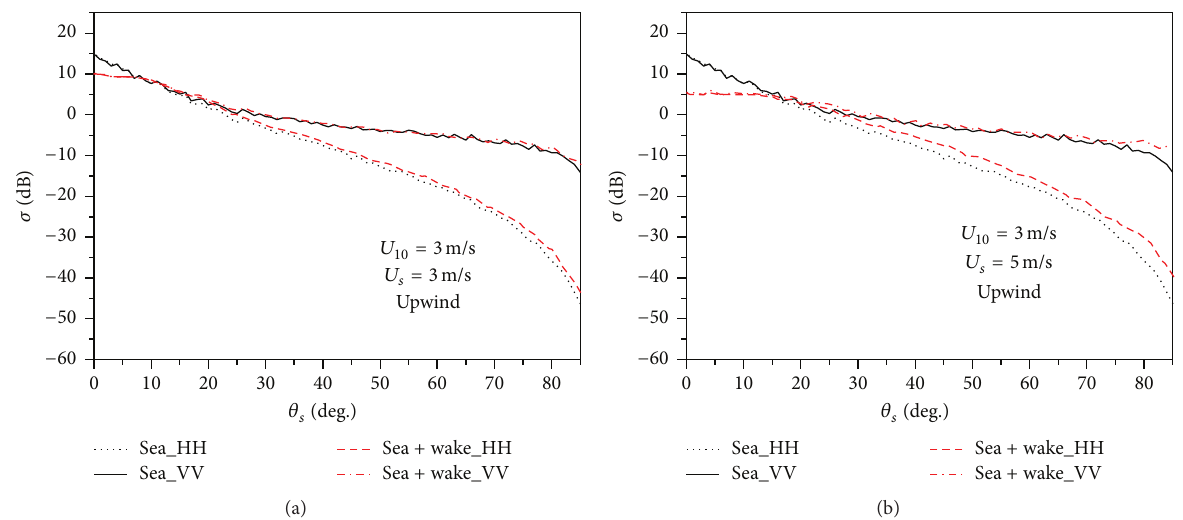
Figure 7: Comparison of copolarized backscattering coefficient from 2D rough sea surface with and without an embedded ship-induced Kelvin wake with wind speed 𝑈 10 = 3 m/s. (a) Ship speed 𝑈 𝑠 = 3 m/s and (b) ship speed 𝑈 𝑠 = 5 m/s.